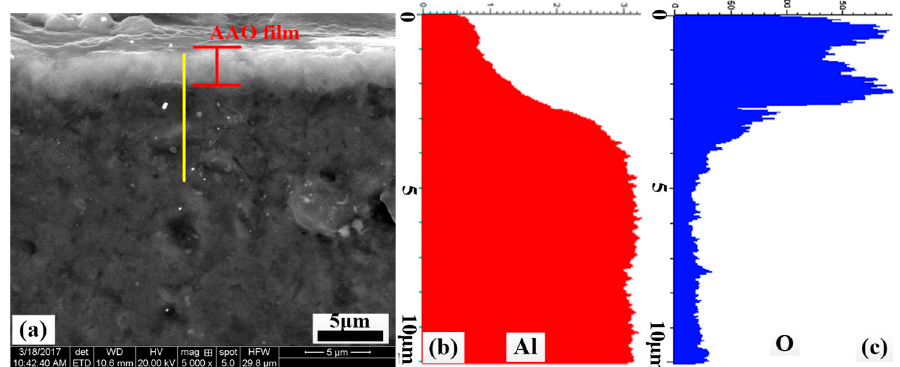
Figure 3. Cross-sectional SEM morphology of anodized ( a ) ZL109; and corresponding EDS line scan of ( b ) Al; ( c ) O element.